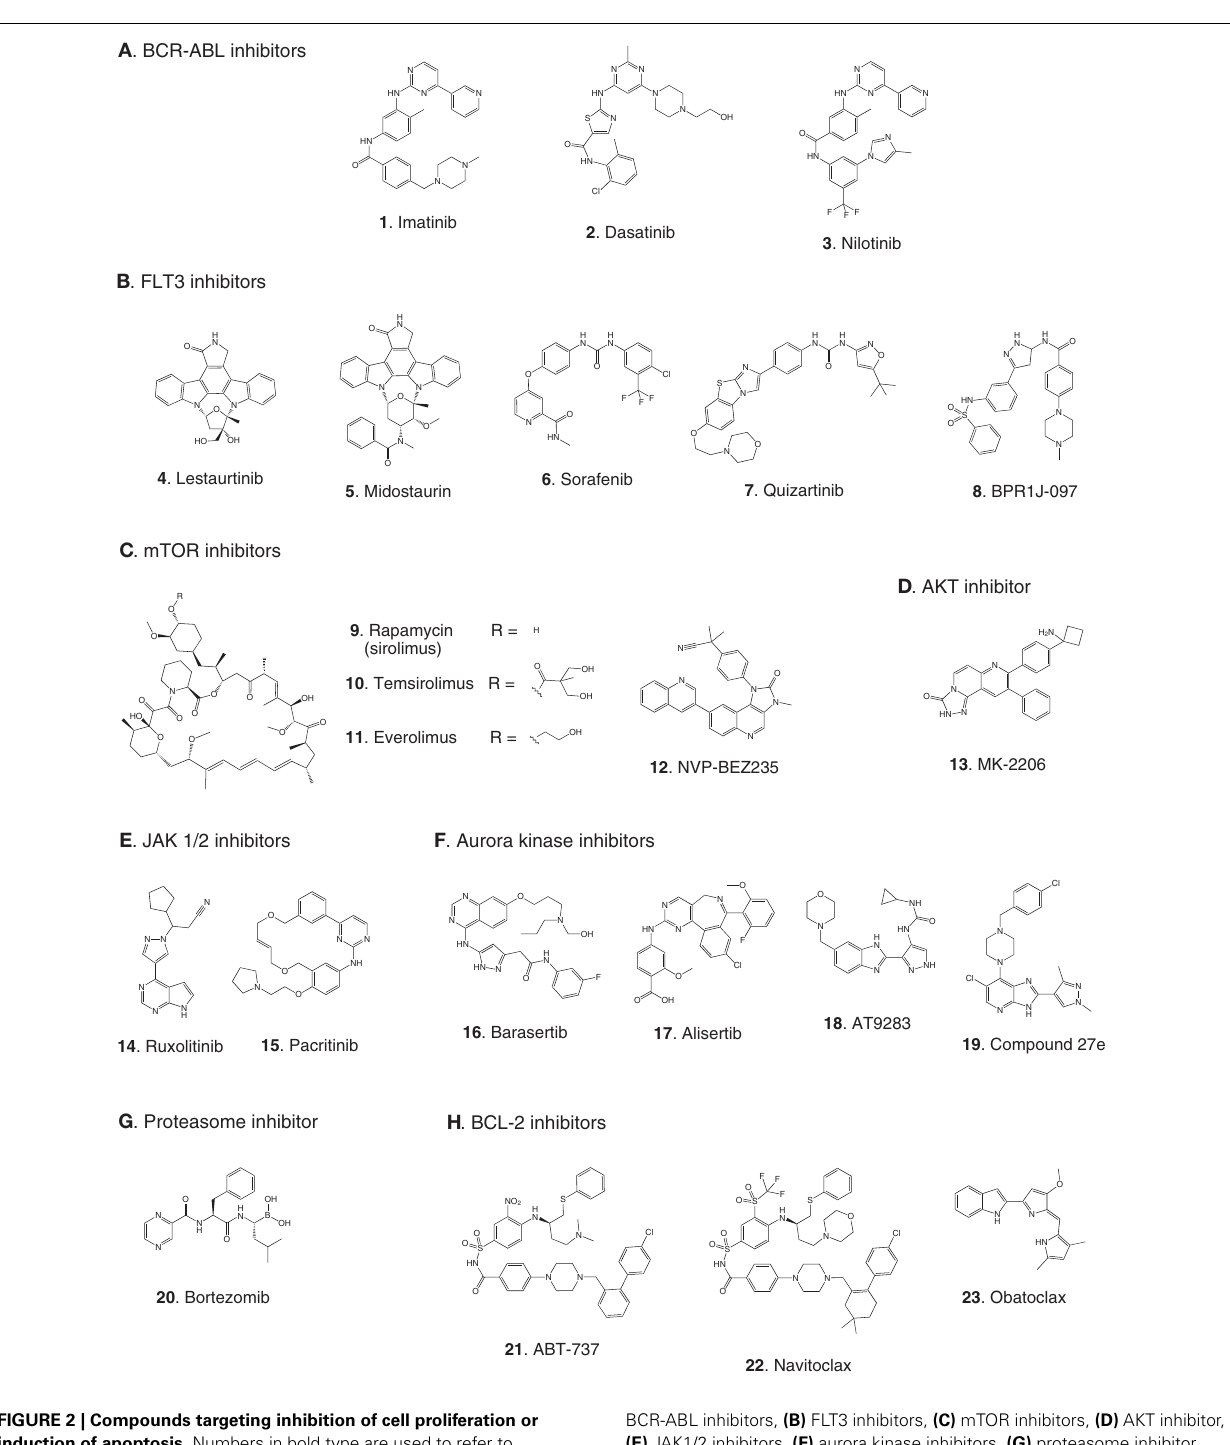
FIGURE 2 | Compounds targeting inhibition of cell proliferation or induction of apoptosis . Numbers in bold type are used to refer to compounds in this figure from the main text, Figure 4 , and Table 1 . (A)